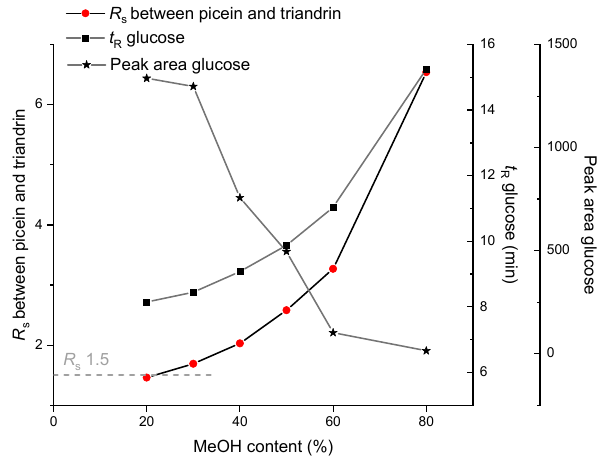
Figure 2. Optimization of eluent conditions (detection ELSD). We chose 30% of MeOH in eluent A (eluent B was ACN, A/B = 20/80) for further studies.